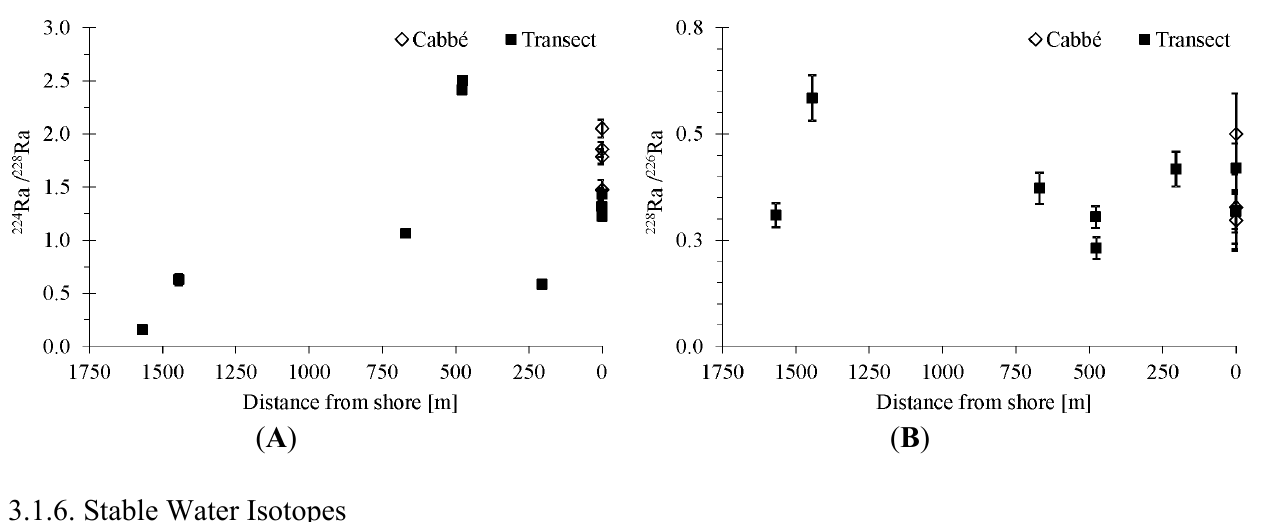
Figure 6. Radium isotope ratios at Cabbé and along the transect. ( A ) 224 Ra/ 228 Ra; ( B ) 228 Ra/ 226